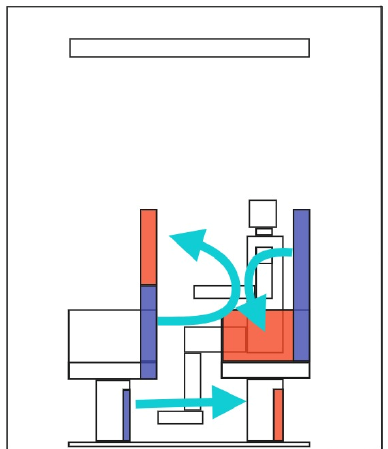
Figure 1. Predicted airflow with inlets (red-colored) and outlets (blue-colored).